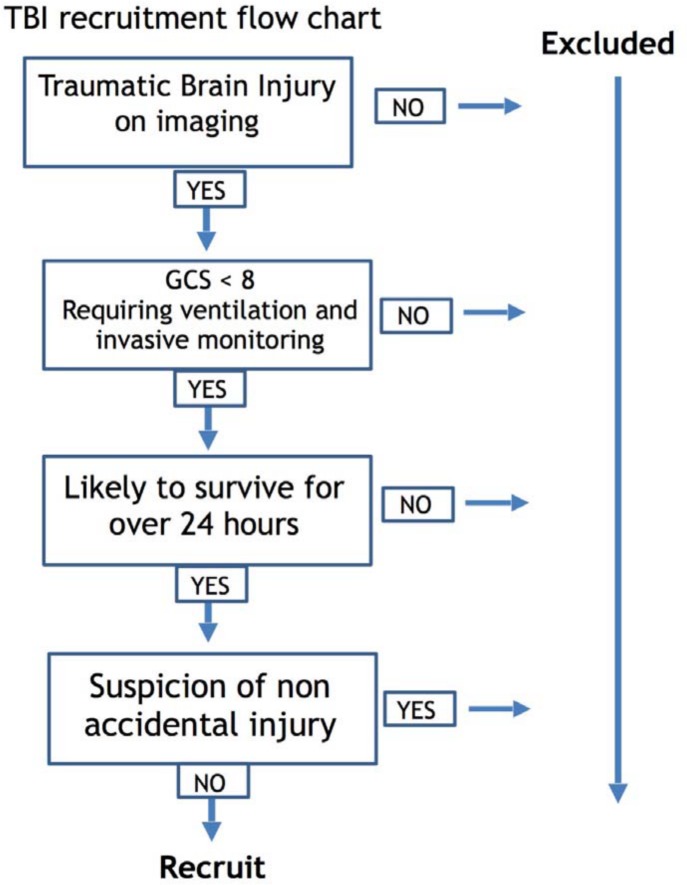
Flow chart demonstrating the recruitment of pediatric traumatic brain injury patients.